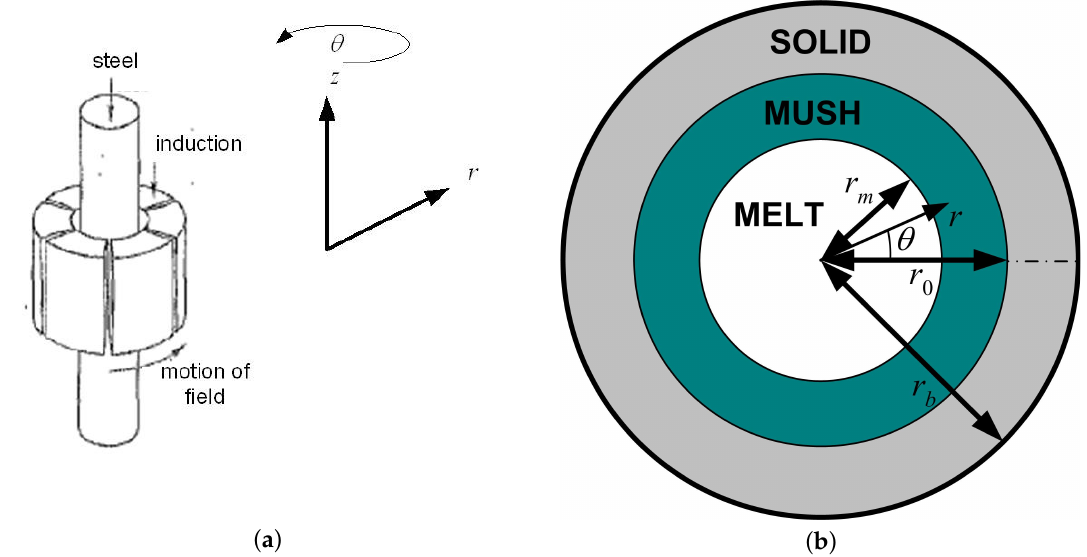
Figure 15. ( a ) Schematic of an arrangement of an inductor around a circular steel strand for inducing rotating fields; and ( b ) schematic of circular solid, mush and melt regions in the cross-section of the